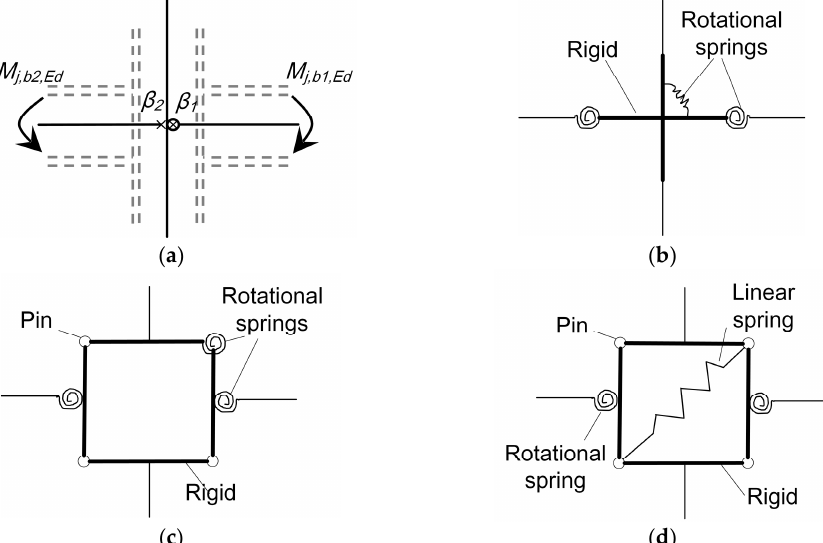
Figure 6. Joint modelling: ( a ) Two separate springs; ( b ) Scissor links; ( c ) Rotational spring box; ( d ) Linear spring.